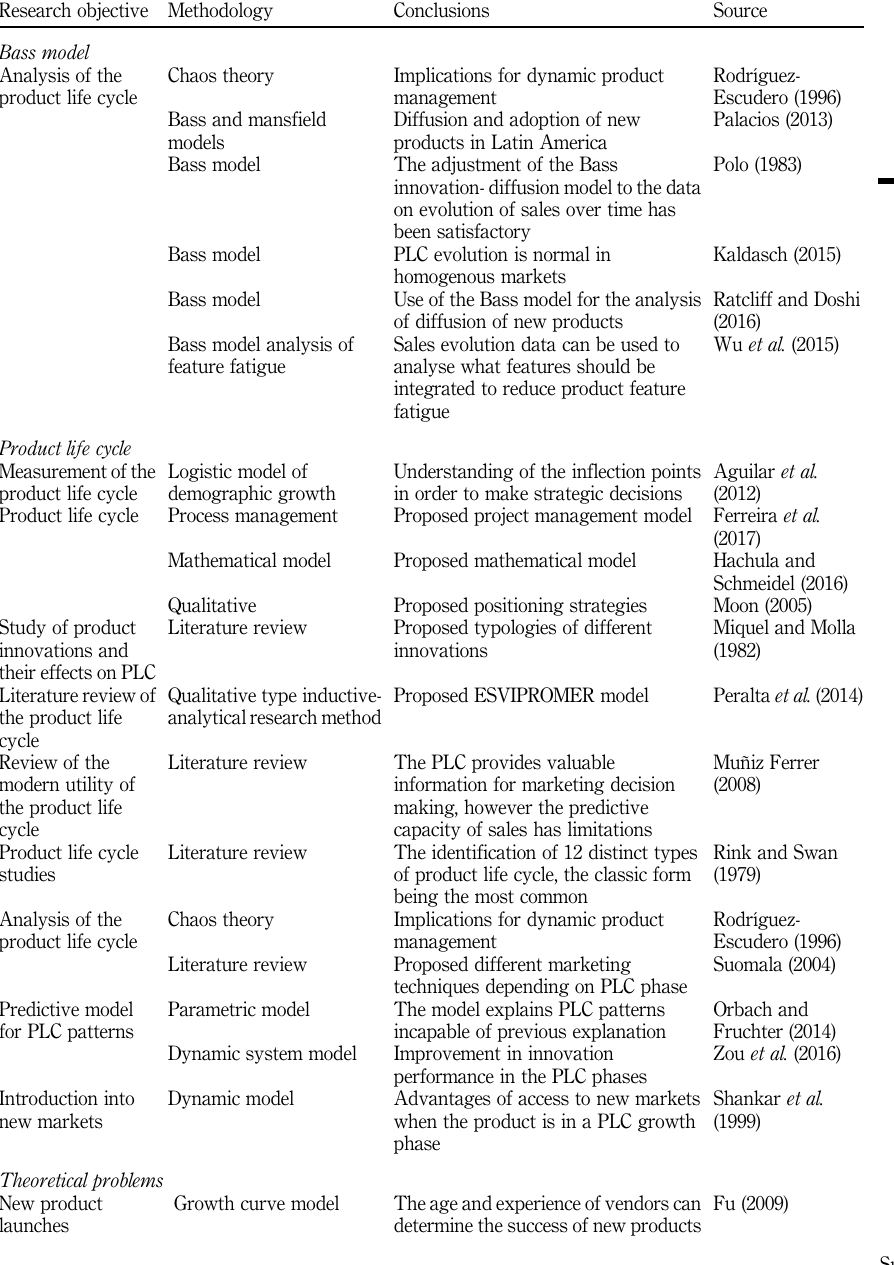
Table II. Summary of the